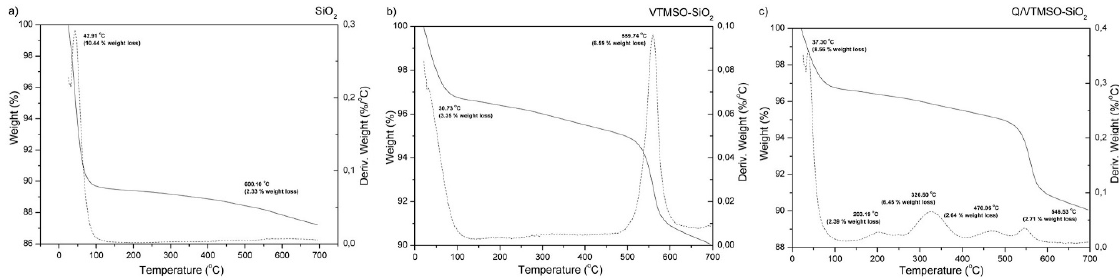
Figure 4. TG-DTG thermograms of SiO 2 ( a ), VTMSO-SiO 2 ( b ), and Q/VTMSO-SiO 2 ( c ).